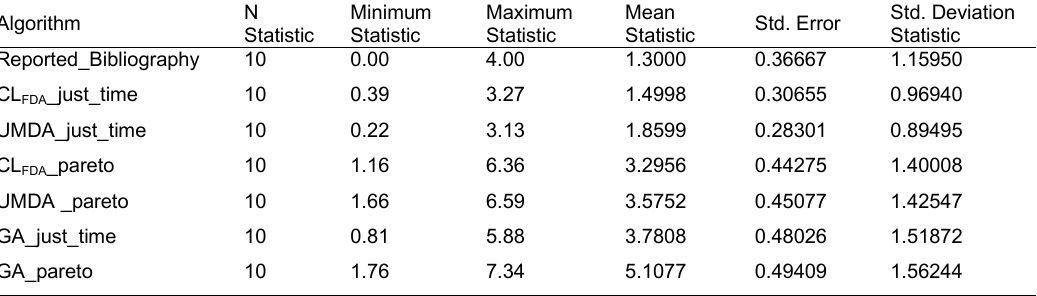
Table 3. Descriptive analysis, variable StdDev_Makespan for j30_17 dataset